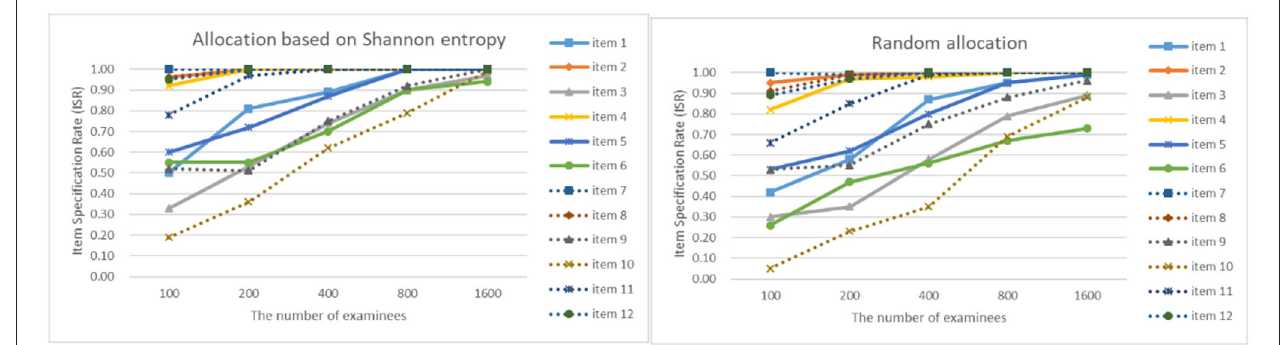
FIGURE 4 | The ISR for two strategies when the initial value of the item parameter is 0.05.